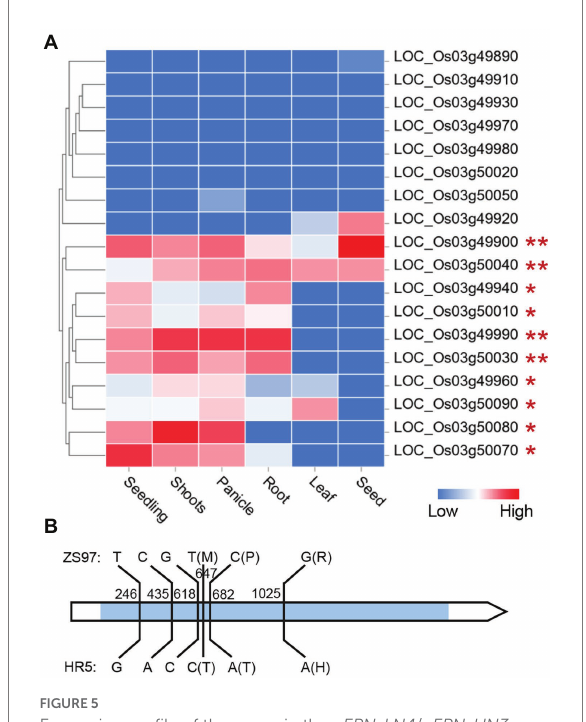
FIGURE 5 Expression profile of the genes in the qEPN-LN4 / qEPN-HN3 locus in different tissues (A) and sequence variations between the SLR1 alleles of the parents (B) . The color bar indicates the relative expression levels. The genes are clustered according to their expression profiles. The genes expressed in both or either the panicle and root are marked by ** or *. The blue rectangle in the gene model indicates the coding region. The relative positions to the start codon of the variations are shown. The amino acid changes induced by non-synonymous mutations are indicated in the